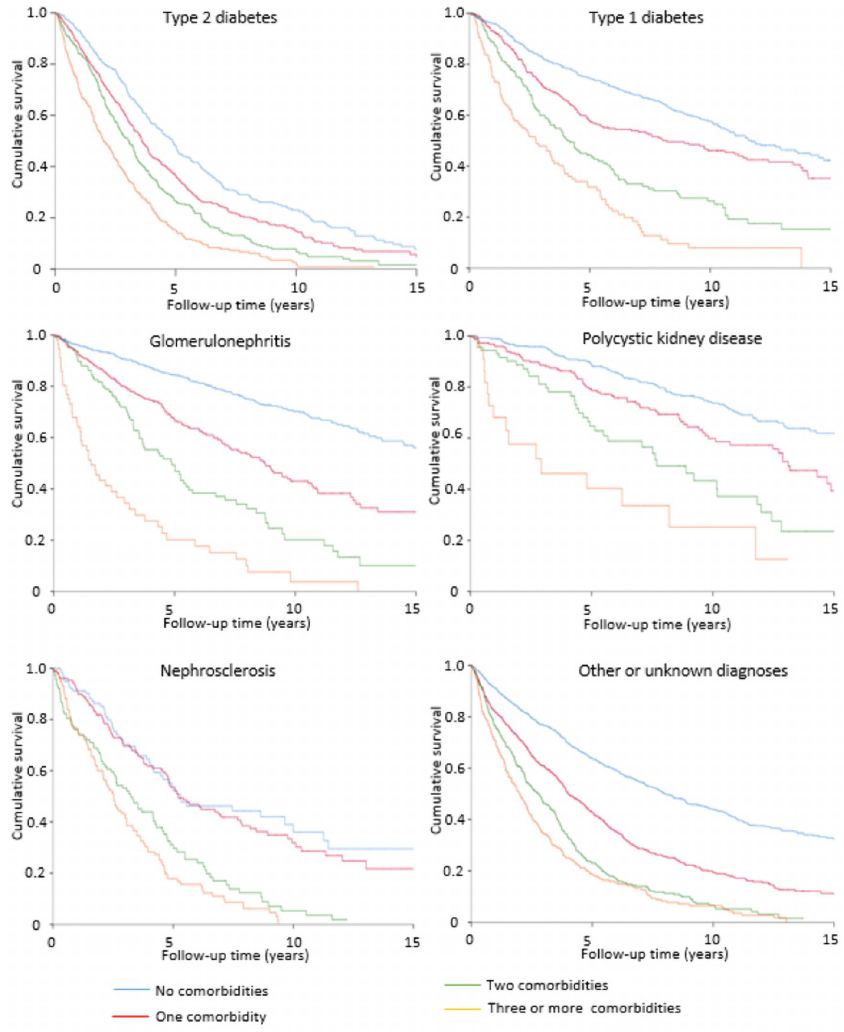
Fig 1. Effect of the number of comorbidities on unadjusted survival probability according to primary kidney disease.